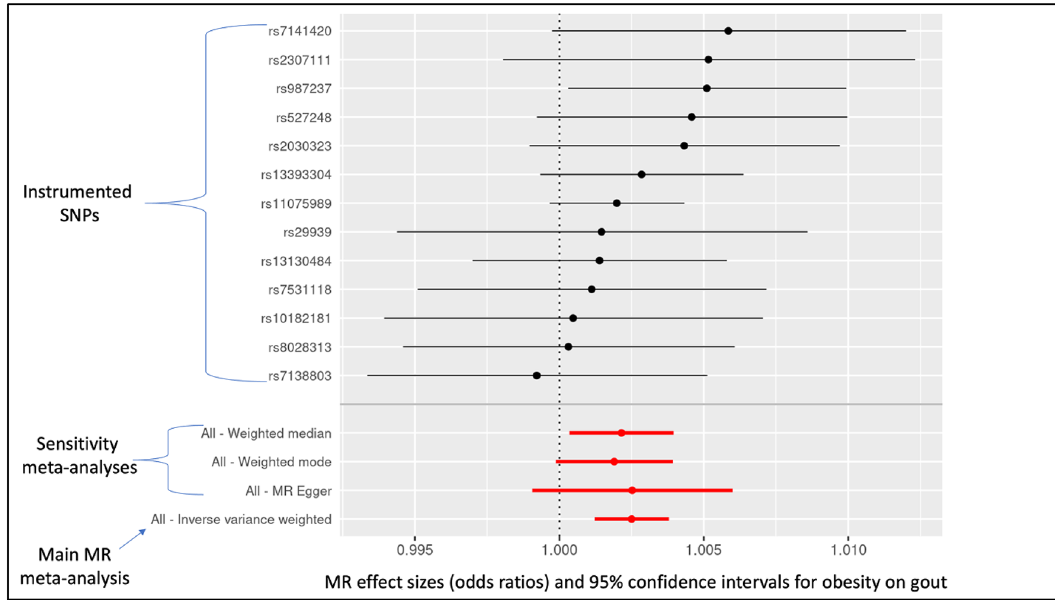
Figure 2. Individual-SNP and meta-analytic MR effect estimates (odds ratios) and 95% confidence intervals for the effect of obesity on gout. Weighted median, weighted mode, and MR-Egger are sensitivity meta-analyses. The inverse-variance weighted (IVW) result is the main MR test.